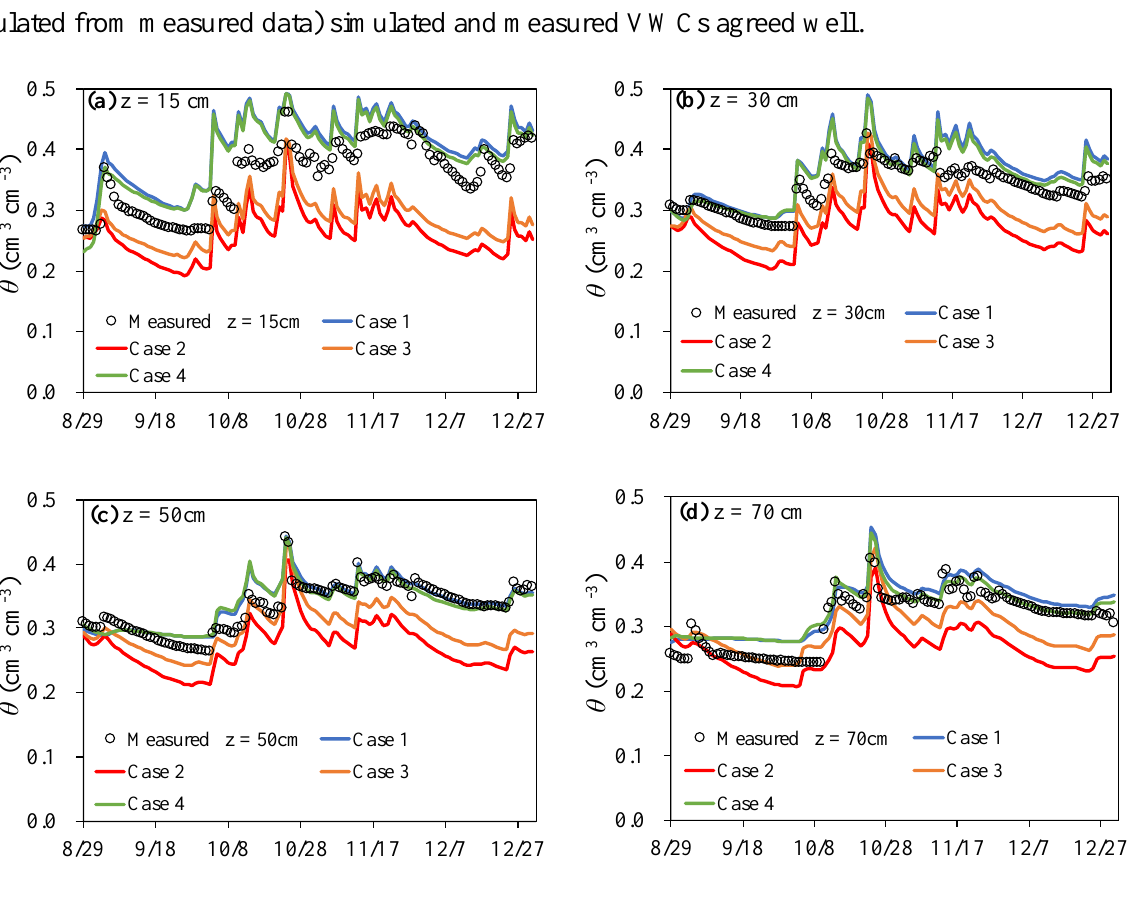
Figure 7. Comparison of simulated and measured daily VWCsat 4 depths from 29 August to 31 December 2009. ( a ) z = 15 cm; ( b ) z = 30 cm; ( c ) z = 50 cm; ( d ) z = 70 cm.